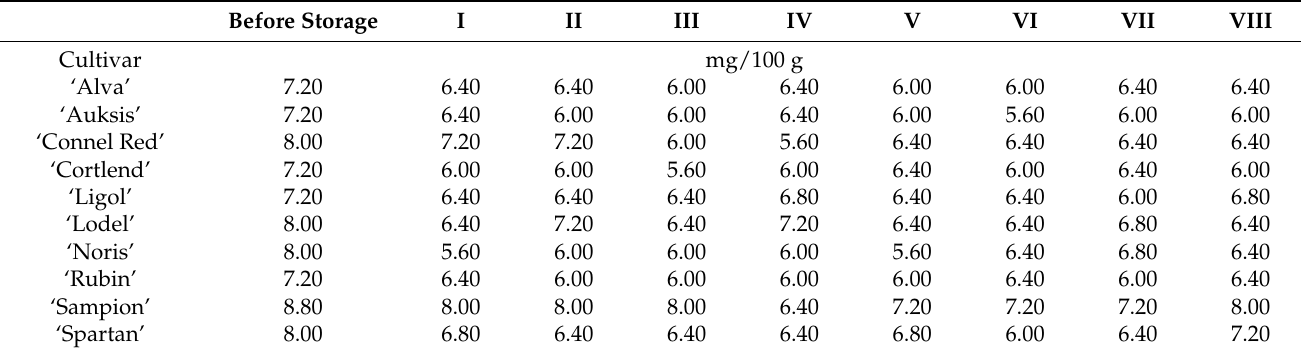
Table 3. Variability of the quantitative composition of ascorbic acid in apple samples before and after storage in CA. Before